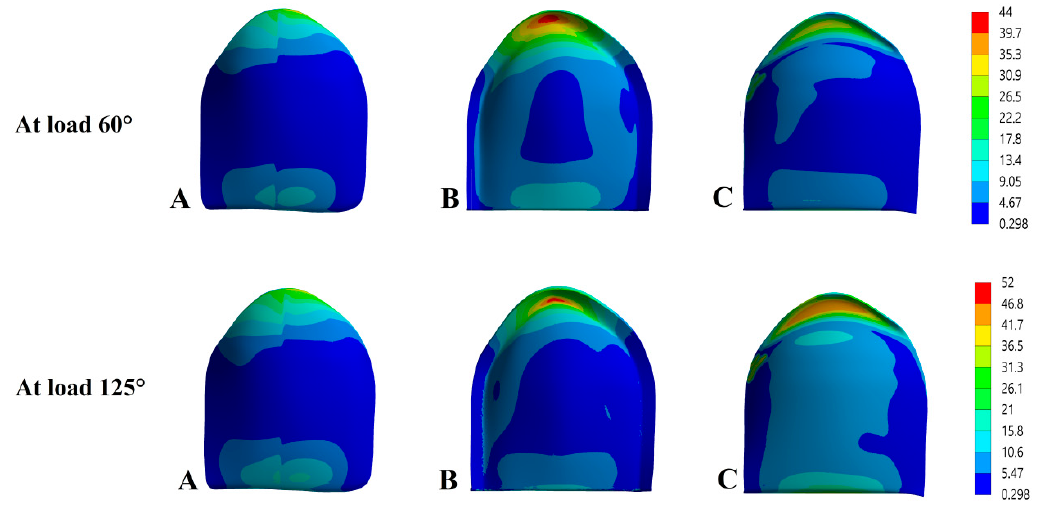
Figure 5. von Mises stress distributions (MPa) in the cement layer. ( A ) Non-preparation design, ( B ) ( B ) conventional preparation design, and ( C ) proposed preparation conventional preparation design, and ( C ) proposed preparation design.